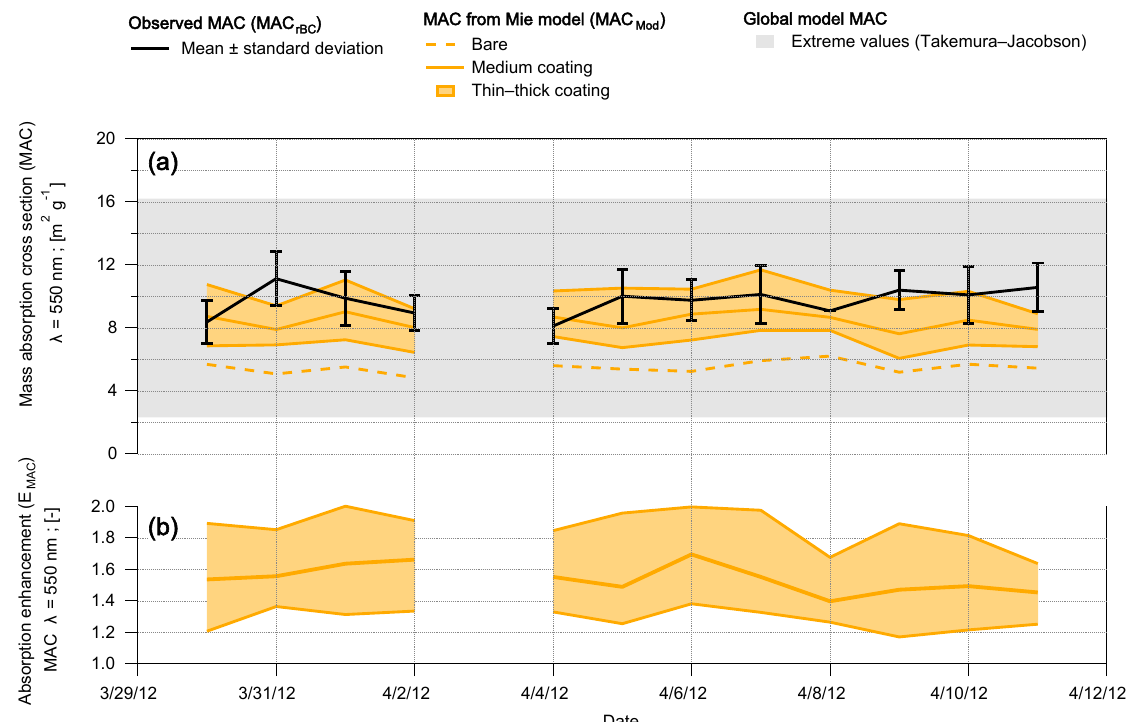
Figure 7. (a) Daily mean values of black carbon mass absorption cross section from observation (MAC rBC ) and from observationally constrained Mie calculations (MAC Mod ). Grey shadows represent the maximum and minimum MAC values used for radiative transfer simulations in global models (Jacobson, 2012; Takemura et al., 2000, 2002, 2005). (b) Daily mean values of absorption enhancement factor defined as the ratio of MAC Mod for coated BC to that of bare BC. All values are for a wavelength of